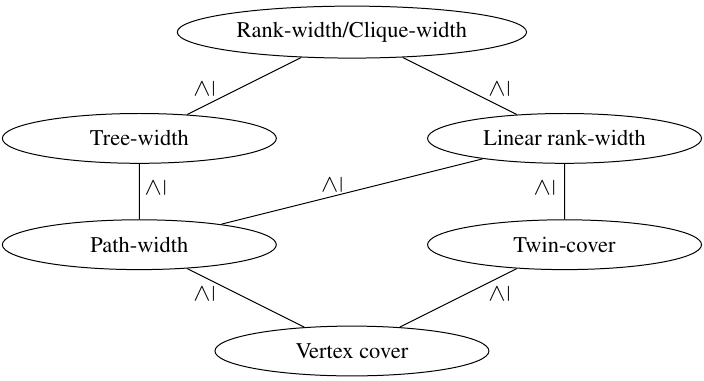
Fig. 3: Relationships between selected graph parameters ( A ≥ B means that there exists a function f such that for all graphs, f ( A ( G )) ≥ B ( G )